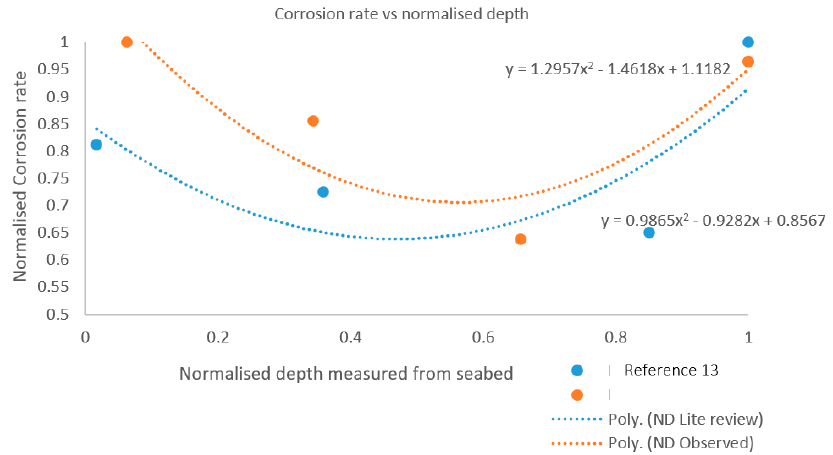
Figure 15. Comparison of literature review considering the normalized depth and corrosion rate.